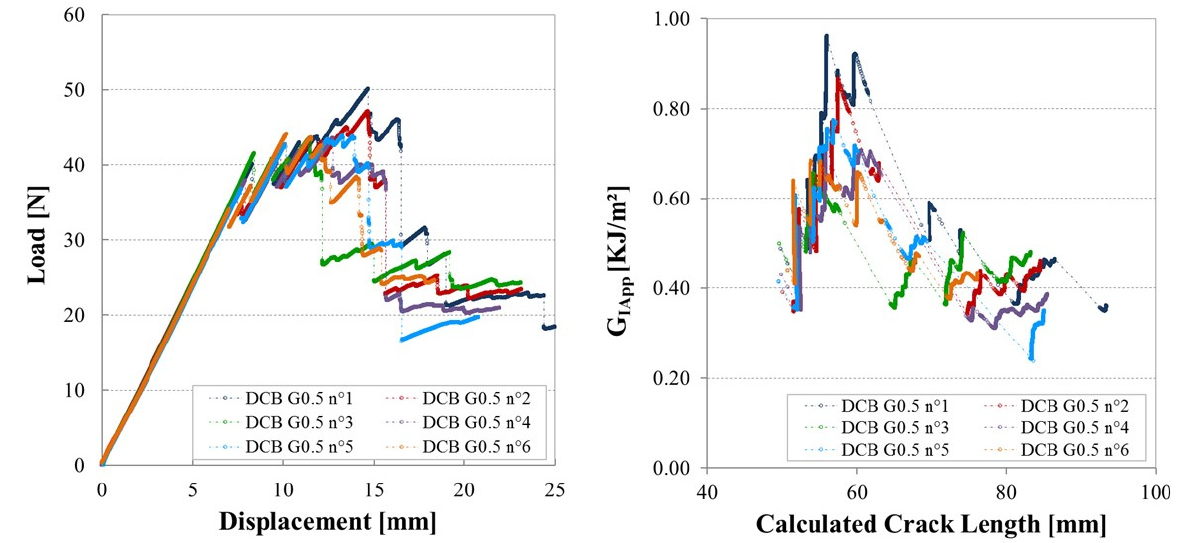
Figure 7. Load vs. displacement traces ( left ) and R-curves ( right ) for cross ply laminates ([90/0 7 /90]s) containing a 0.5 mm gap (considered as reference configuration without defects).